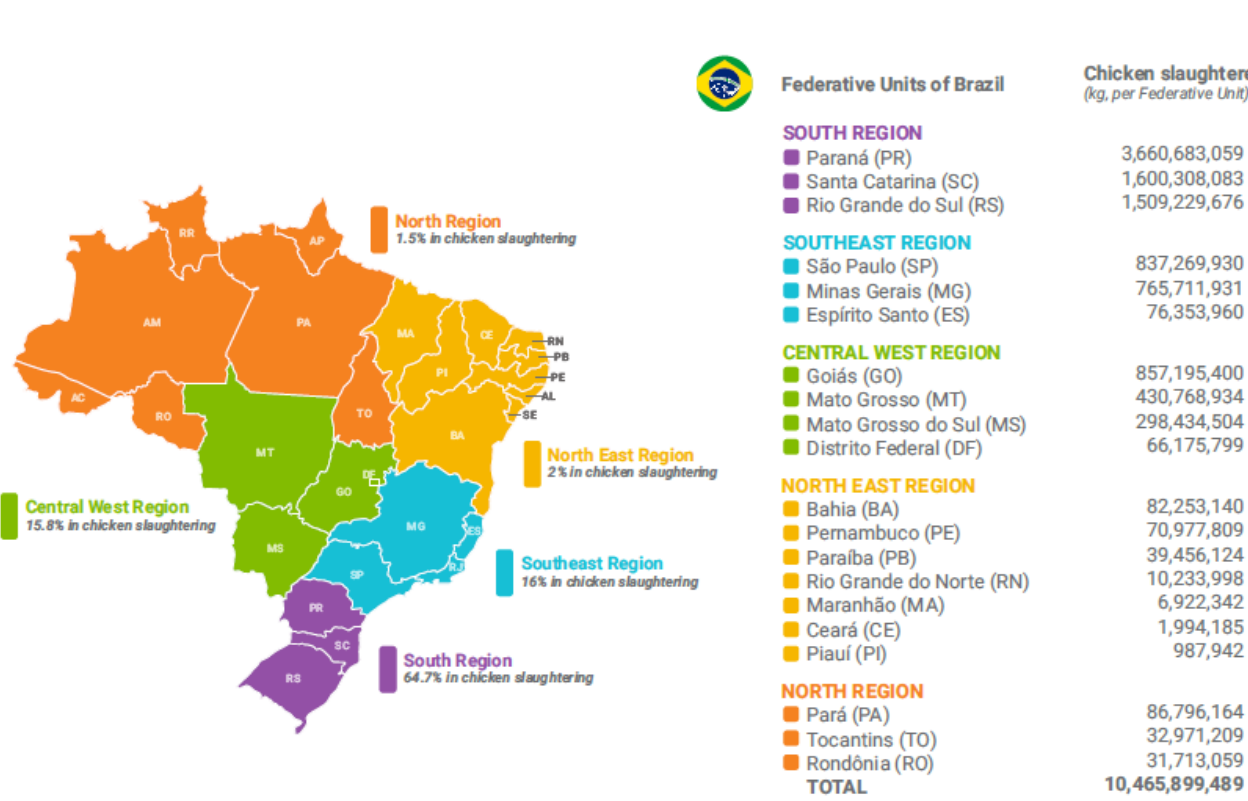
Figure 1. Chicken meat exporting Federative Units (kg/Federative Unit) during 2019-2020.